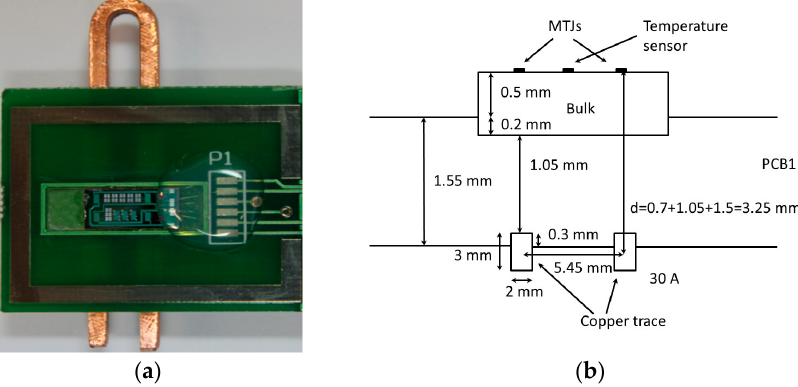
Figure 4. ( a ) Printed circuit board (PCB) including the complete tunneling magnetoresistance (TMR) transducer and the U-shaped copper current trace; ( b ) Cross-section schematics of the geometry used for this device, showing the copper trace dimensions as well as the sensor to trace distance.